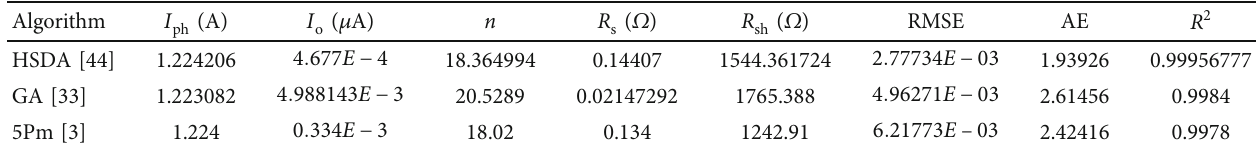
Table 7: The parameters and statistical tests for mSi photovoltaic panel.